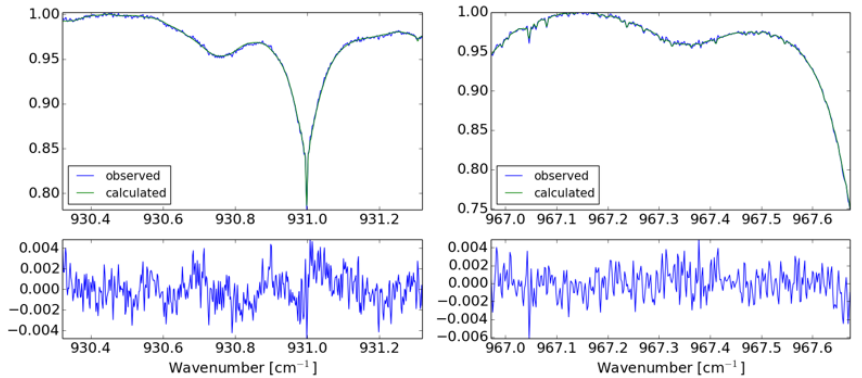
Figure 3. Measured and calculated spectrum for both spectral windows measured with the 125HR in Bremen on the 19 April 2010 at 09:59UTC, corresponding to a total column of 18 . 83 × 10 15 molecules NH 3 cm − 2 . The top two panels show the observed (blue line) and calculated (green line) spectra for MW1 (left) and MW2 (right). The bottom two figures show the residuals of the fits in both spectral windows.